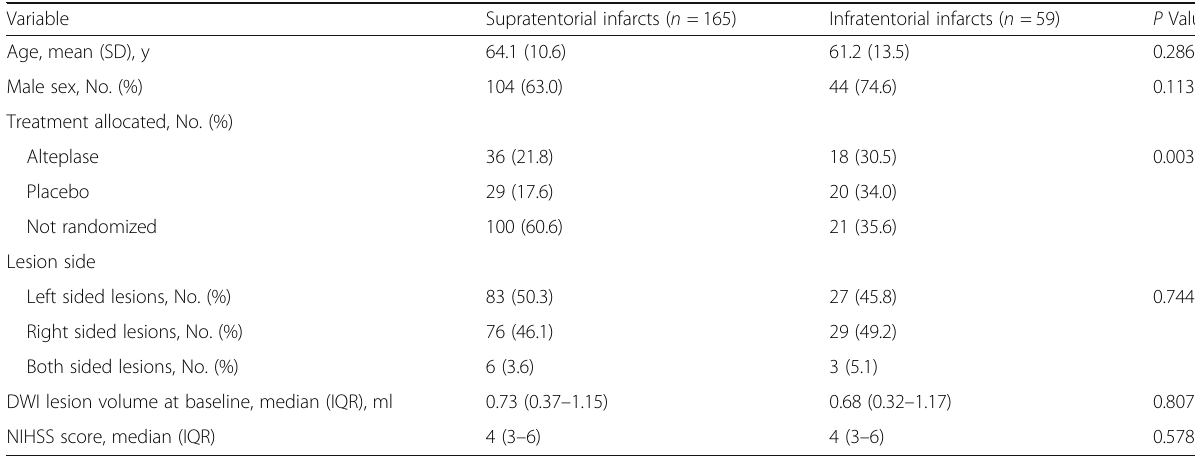
Table 1 Baseline